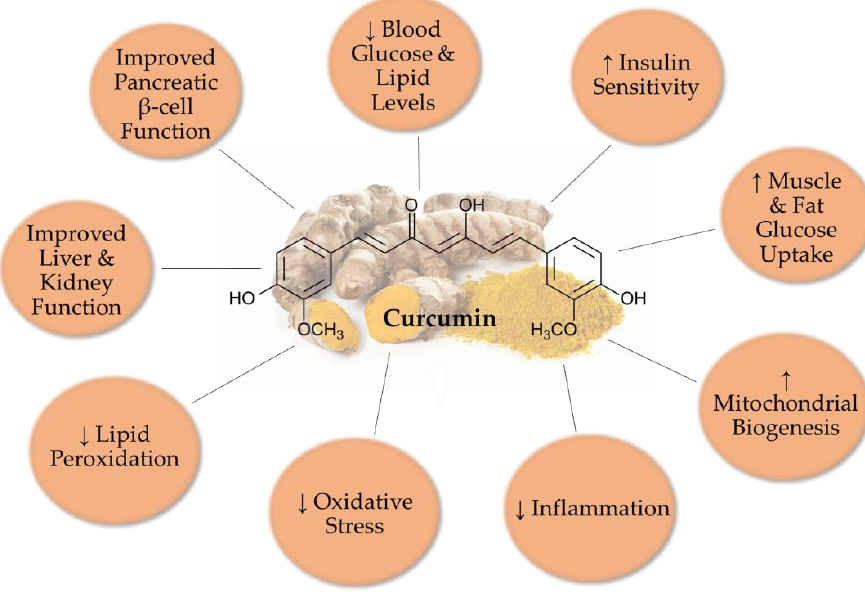
ff ects of curcumin in T2DM animal Figure 2. Overall effects of curcumin in T2DM animal models. Figure 2. Overall e